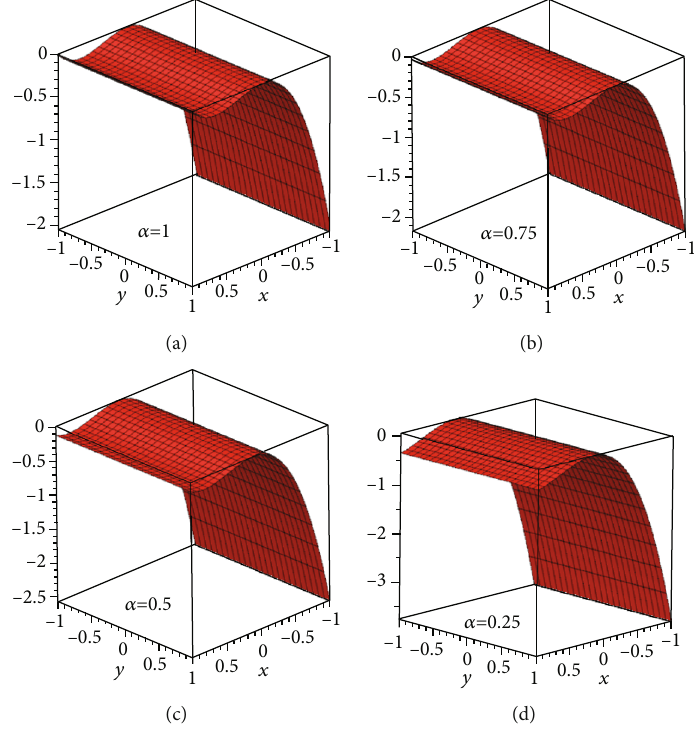
Figure 2: Nature of the proposed method solutions at di ff erent fractional orders for problem 2.